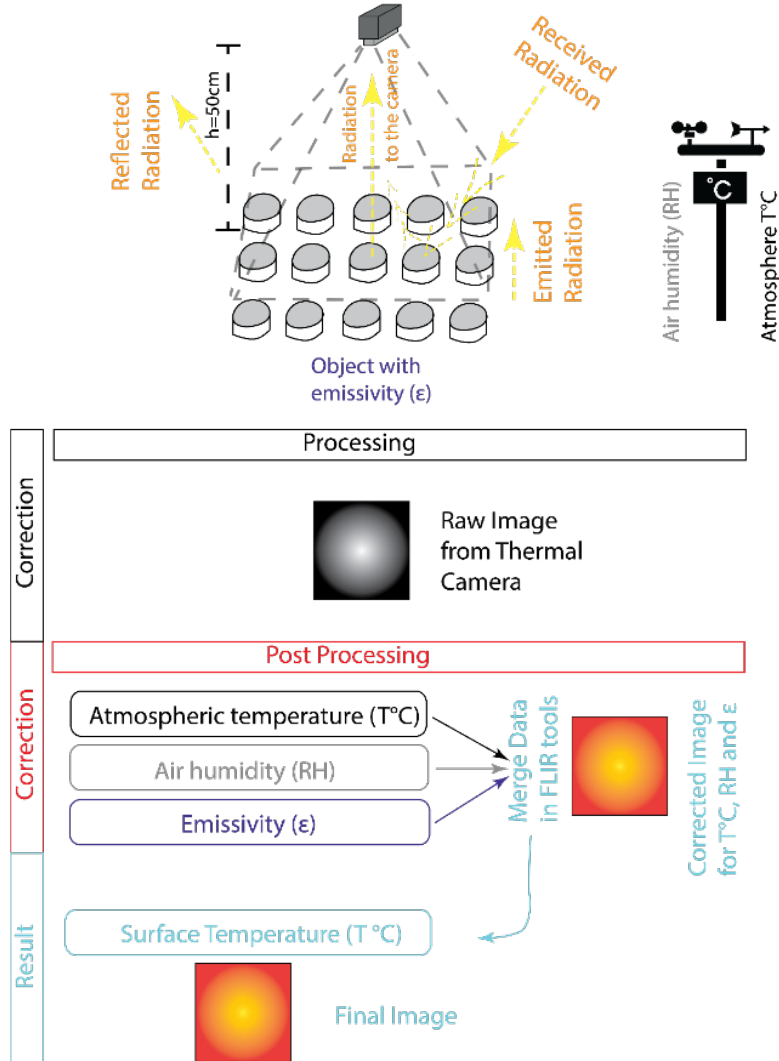
Figure 2. ( top ) Sketch of the acquisition system and heat transfers between the samples and the atmosphere; ( bottom ) post-processing scheme.